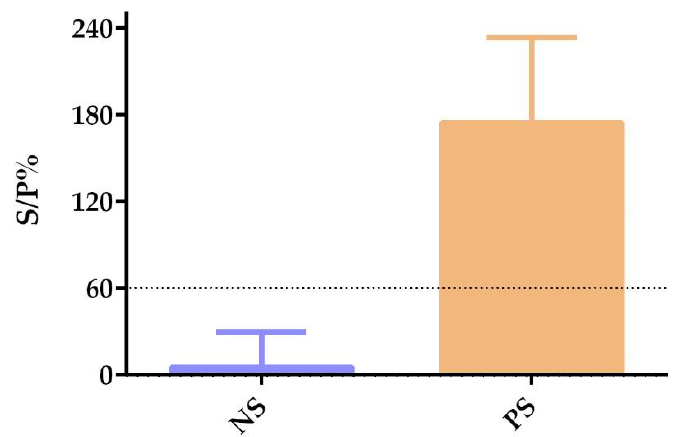
Figure 3. Anti-SARS-CoV-2 antibody screening results by ELISA. S/P% of negative samples (NS) and positive samples (PS) are represented by bar graph showing mean + standard deviation. The dotted line represents S/P% cutoff. Table 3. Characterization of SARS-CoV-2-seropositive cats.